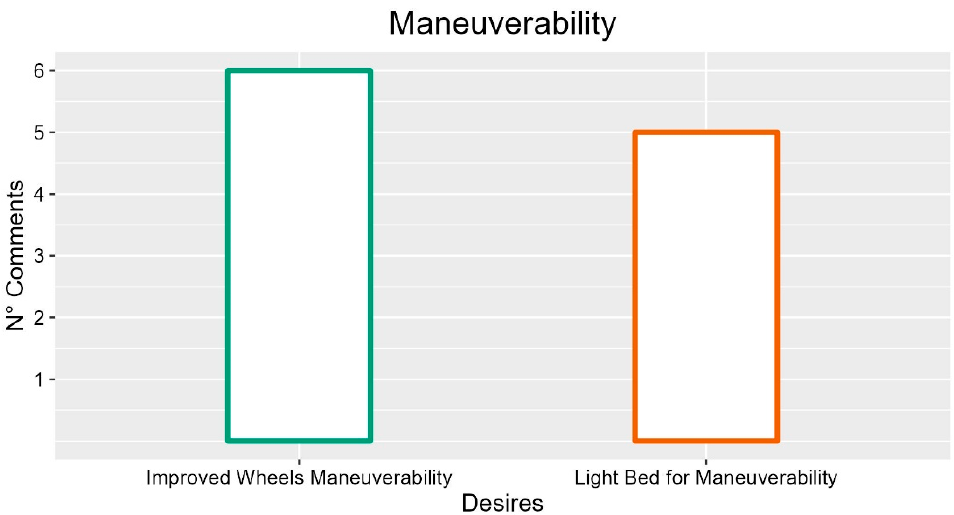
Figure 13. Graphical representation of desires with more occurrences for the Maneuverability theme.